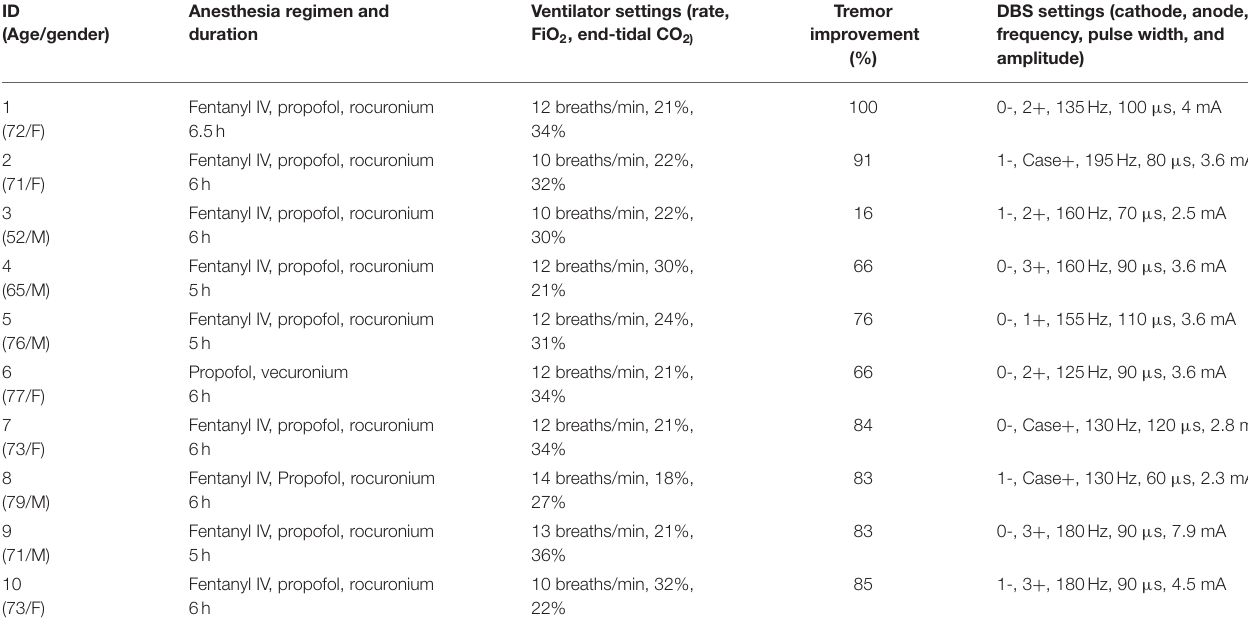
TABLE 1 | Demographics, anesthesia regimen, tremor improvement and DBS settings. ID Anesthesia regimen and (Age/gender) duration